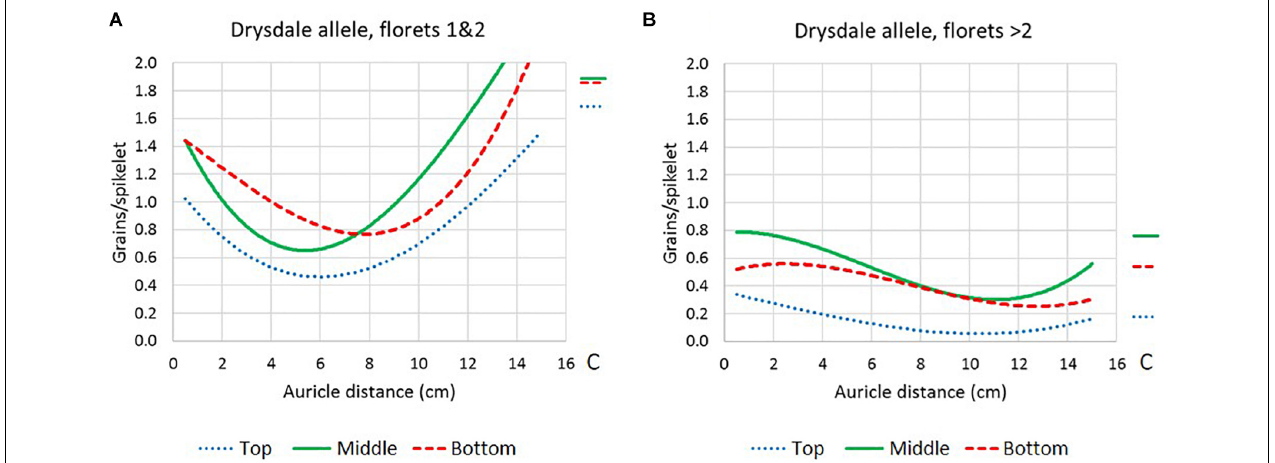
FIGURE 2 | Floret fertility response curves (polynomial regression, order-3) in Drysdale × Waagan DH lines that had been heat treated at different stem developmental stages as defined by auricle distance, in the top, middle, and bottom third of the spike. Only lines carrying the Drysdale (intolerance) allele at WtmsDW are represented. (A) Floret positions 1 and 2 in the spikelets. (B) Floret positions > 2 in the spikelets. Average fertility in control plants C are represented by the lines to the right of the